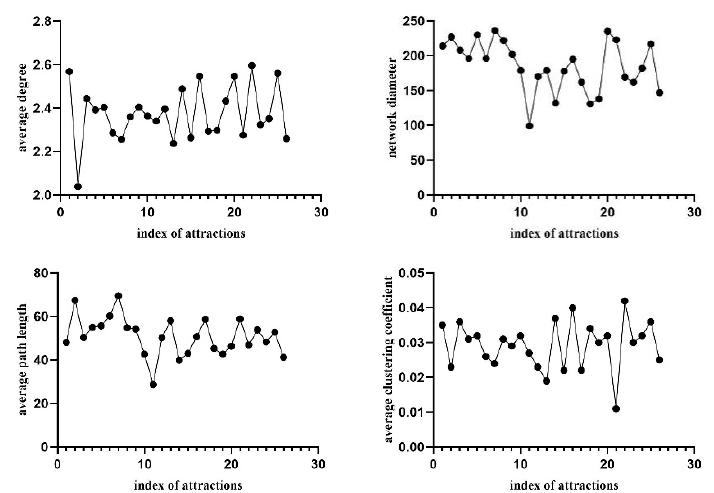
Figure 12. Complex network metrics for the travel networks of each attraction.